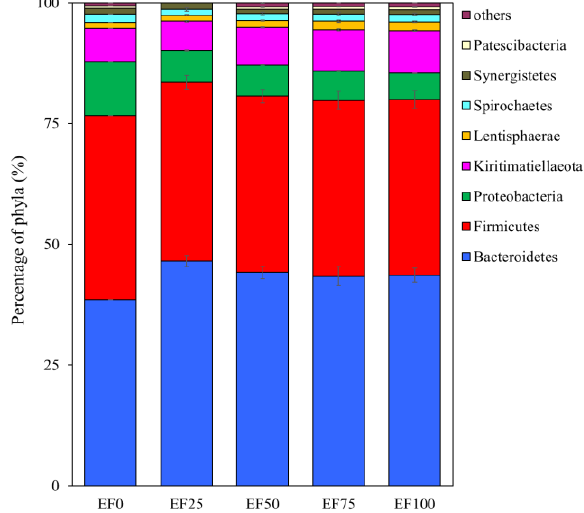
Figure 2. Phylum composition of rumen microbiota. Different addition levels of endophyte-free Achnatherum inebrians (EF) changed the composition of ruminal microbiota at the phylum levels showed as relative abundance. Only phylum with a relative abundance greater than 0.5% are depicted. EF0, EF25, FE50, EF75, and EF100 are defined as EF replacement ratios of 0%, 25%, 50%, 75%, and 100% of the fermentation substrate, respectively.